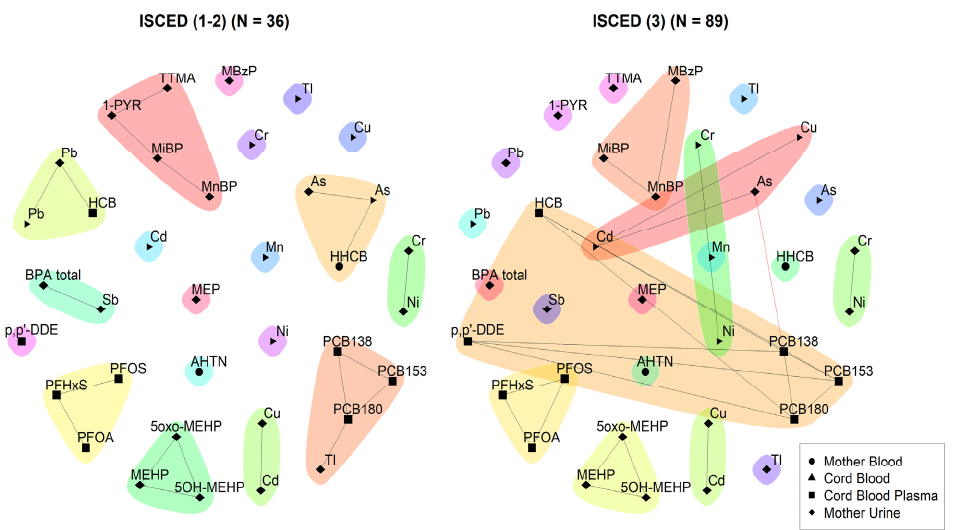
Figure 6. Unweighted network for 3xG for participants with low educational level ( left ) and participants with high educational level ( right ). The data were corrected for age and BMI. Urinary markers were standardised for creatinine and lipid soluble blood markers were standardised for lipids. Low ISCED is defined by participants belonging to educational levels 0–4 according to the ISCED (International Standard Classification of Education) and high ISCED is defined by participants belonging to educational level ≥ 5. Black lines indicate dependency between nodes (biomarkers) within a community; red lines indicate dependency between nodes in different communities.